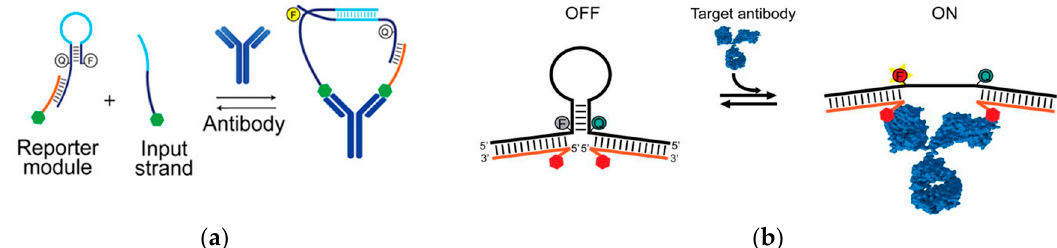
Figure 7. ( a ) With the presence of the target antibody, the reporter module and input strand are in close proximity with each other which brings up the efficiency of hybridization. The binding of the recognition elements and the target antibodies leads to the release of the signal from the fluorescence/quencher pair. The signal gain is recorded with different concentrations. (Adapted with permission from Ref. [60] Copyright 2018 American Chemical Society.) ( b ) The binding of the target antibody to the recognition elements on two single-stranded tails opens the stem-loop structure, leading to the release of the fluorescence signal (adapted from Ref. [61], copyright 2015 WILEY-VCH Verlag GmbH & Co. KGaA, Weinheim).